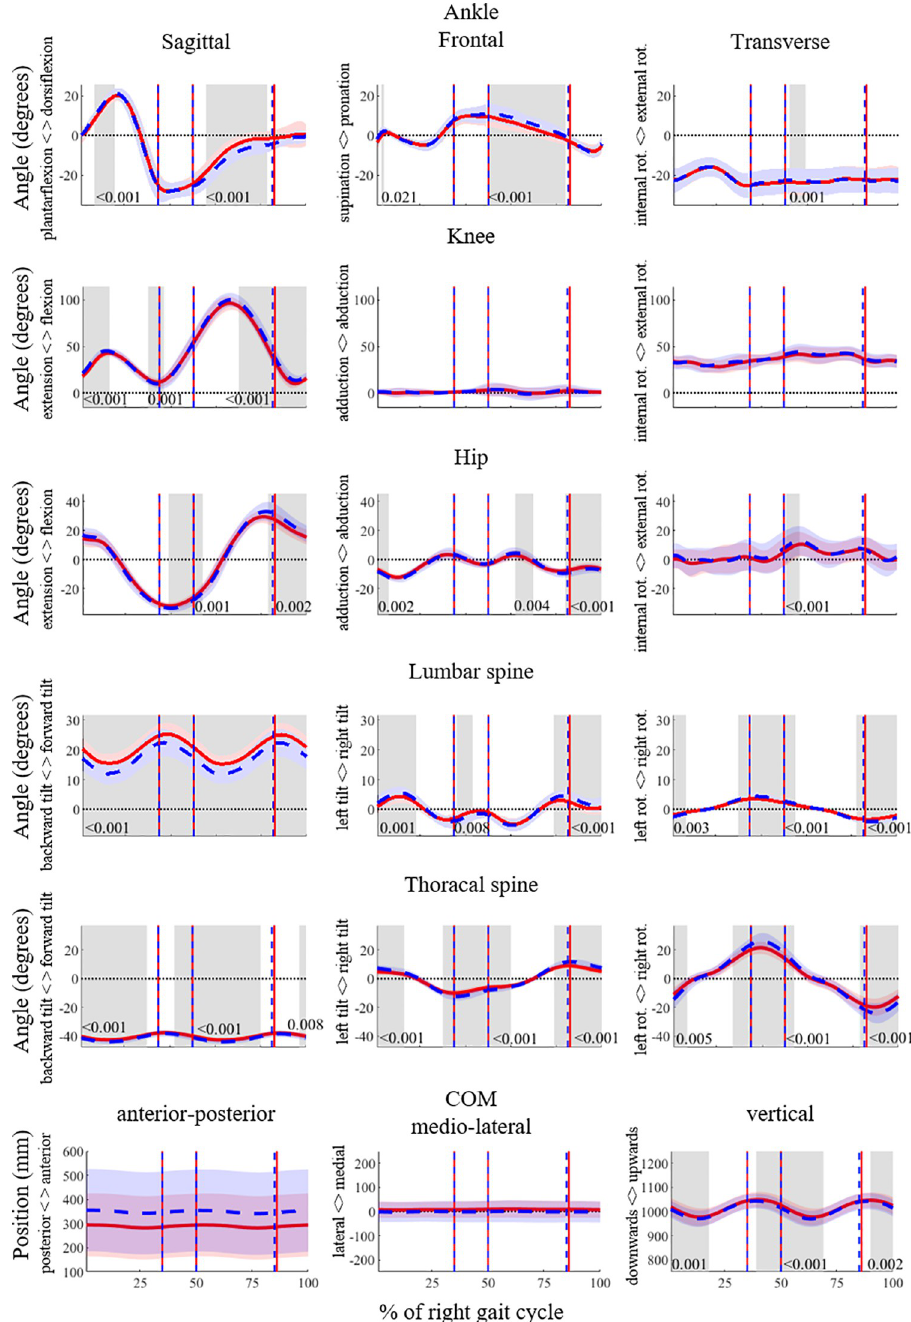
Fig 2. Time series of the joint angles and the CoM. SPM analyses for the angles of the ankle, knee, hip (right side), lumbar spine and thoracic spine in degrees and of the trajectory of the center of mass (CoM) in mm for the entire running gait cycle (from right foot strike to right foot strike) in 3D. The PRE and POST time series data are shown in red and blue, respectively. Significant differences (p < 0.05) are highlighted with grey areas and corresponding p- values are given. RTO signifies right toe-off, LFS left foot strike and LTO left toe-off.